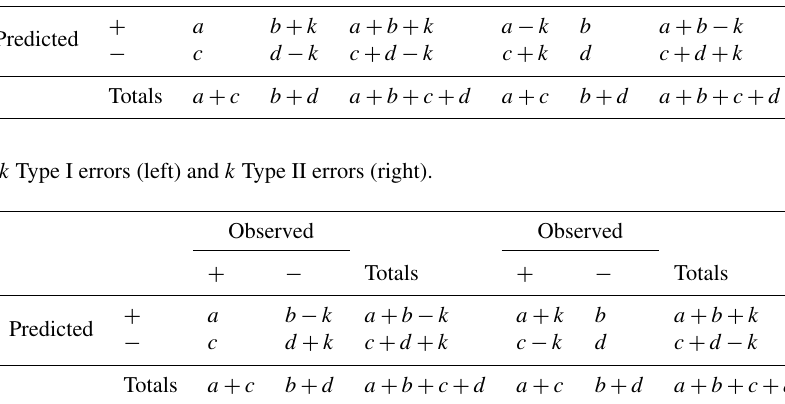
Table B1. An increase in k Type I errors (left) and k Type II errors (right). Observed Observed + − Totals + − Totals + Predicted